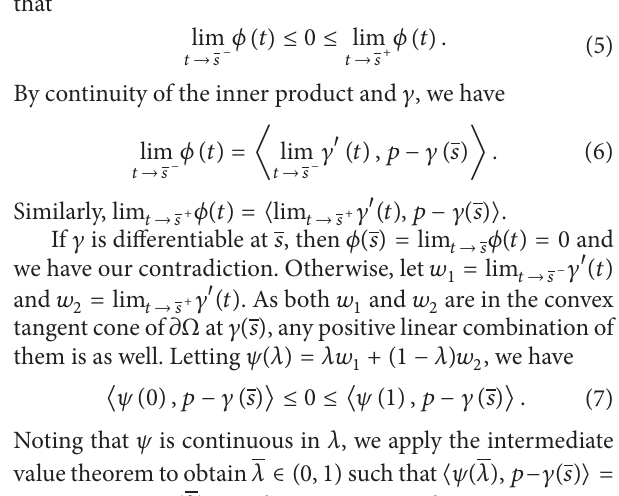
Figure 5: The two-arc property for 𝑟 = ̂𝑟 does not imply that it holds for all 𝑟 < ̂𝑟